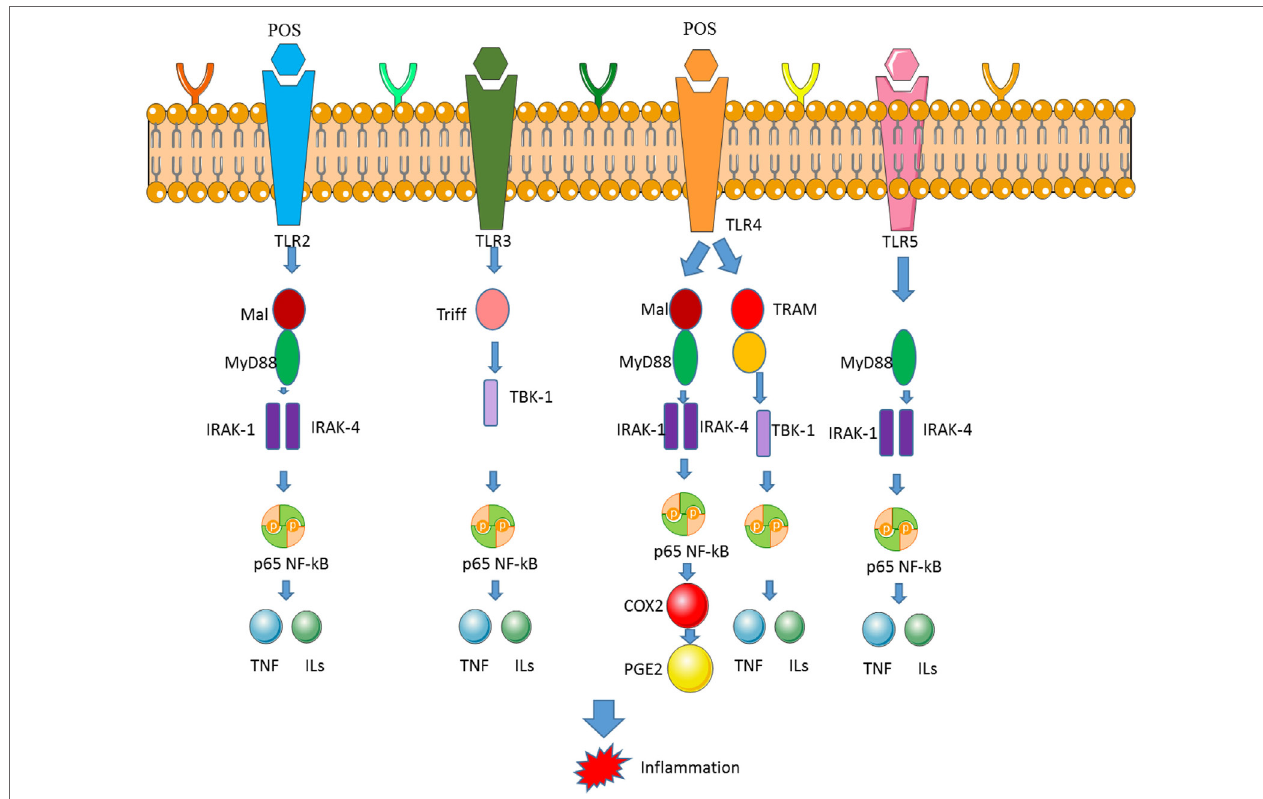
FiguRe 6 | Pectin oligosaccharides (POS) downregulates the expression of nuclear factor-kappa B (NF- κ B) and COX-2 by binding toll-like receptor 4 (TLR4). The binding between TLR4 and POS activates NF- κ B and COX-2 signaling pathway, which is associated with inflammatory activities.